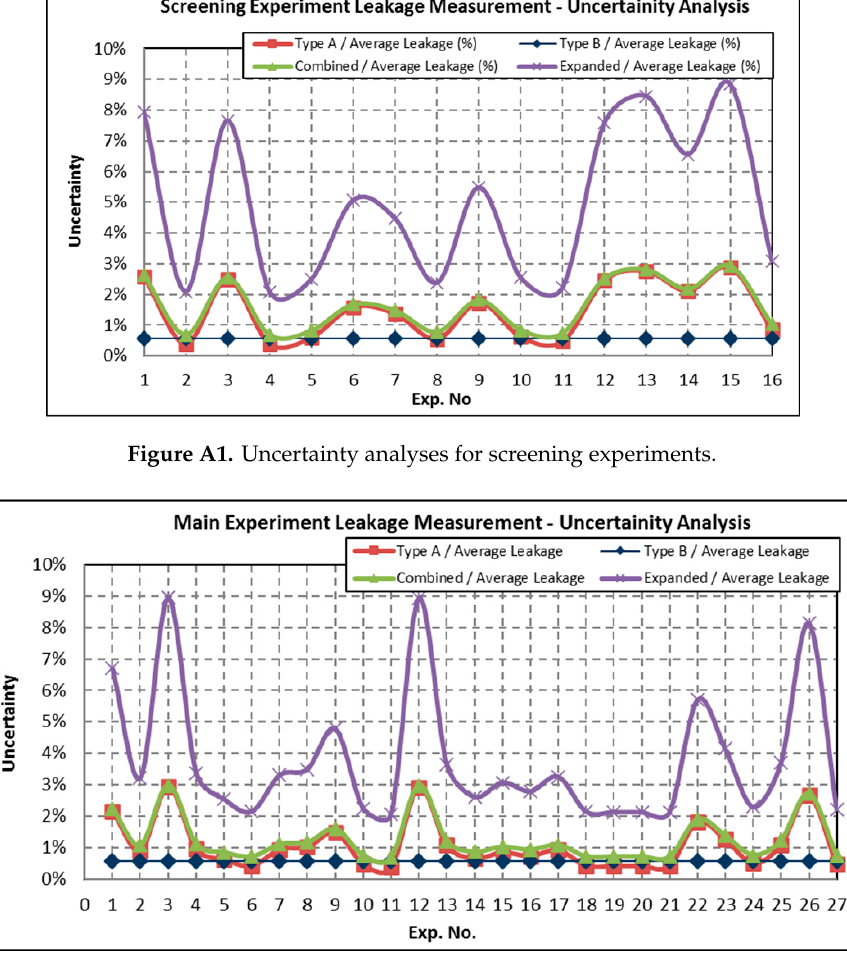
Figure A2. Uncertainty analyses for main experiments.